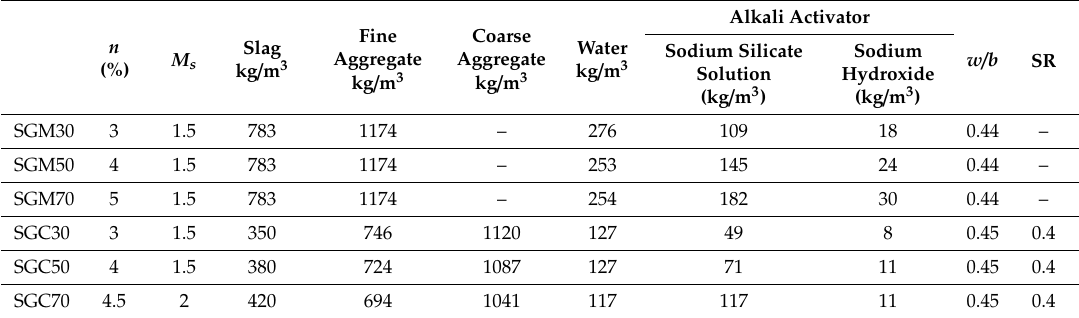
Table 3. Mix proportions of the slag-based geopolymer mortar (SGM) and the slag-based geopolymer cement (SGC)